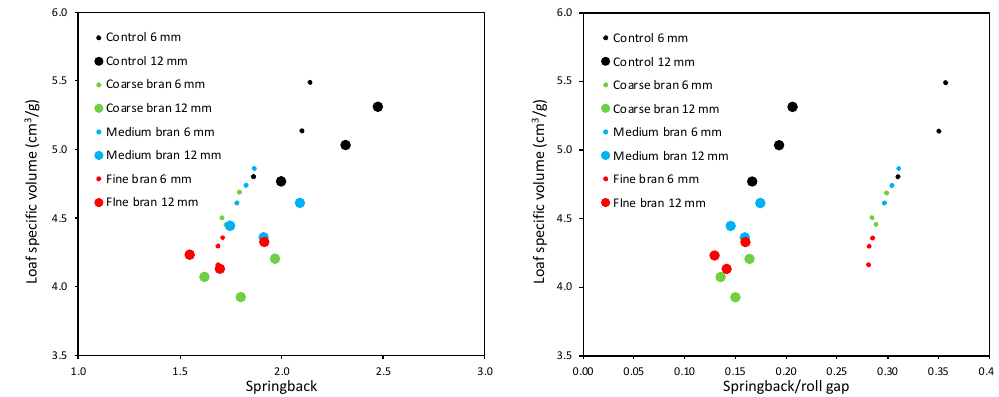
Figure 9. Average specific volume of baked loaves containing 10% Fine, Medium and Coarse bran, for doughs sheeted at roll gaps of 6 mm ( left ) and 12 mm ( right ) for 4, 8 and 12 sheeting passes. Control doughs without bran gave the largest loaf volumes, and volume increased as sheeting increased from 4 to 8 to 12 passes at both roll gaps. Loaves were on average 5.2% larger after sheeting at a 6 mm roll gap compared with 12 mm, reflecting greater gluten development at the smaller gap. Bran decreased loaf volume, with Fine bran once again the most damaging and Medium bran the least, and with sheeting for 8 passes once again optimal compared with 4 or 12 passes. Figure 11 shows images of bread samples made without bran and with 10% Coarse, Medium and Fine bran, and with eight sheeting passes at a 6 mm roll gap. The images are ordered from highest to lowest volume, highlighting that Medium bran gave larger loaf volumes than Fine or Coarse, although still a lot lower than the Control without bran. Zhang and Moore [17] similarly found that their Medium bran gave the highest loaf volume and Fine bran the lowest.